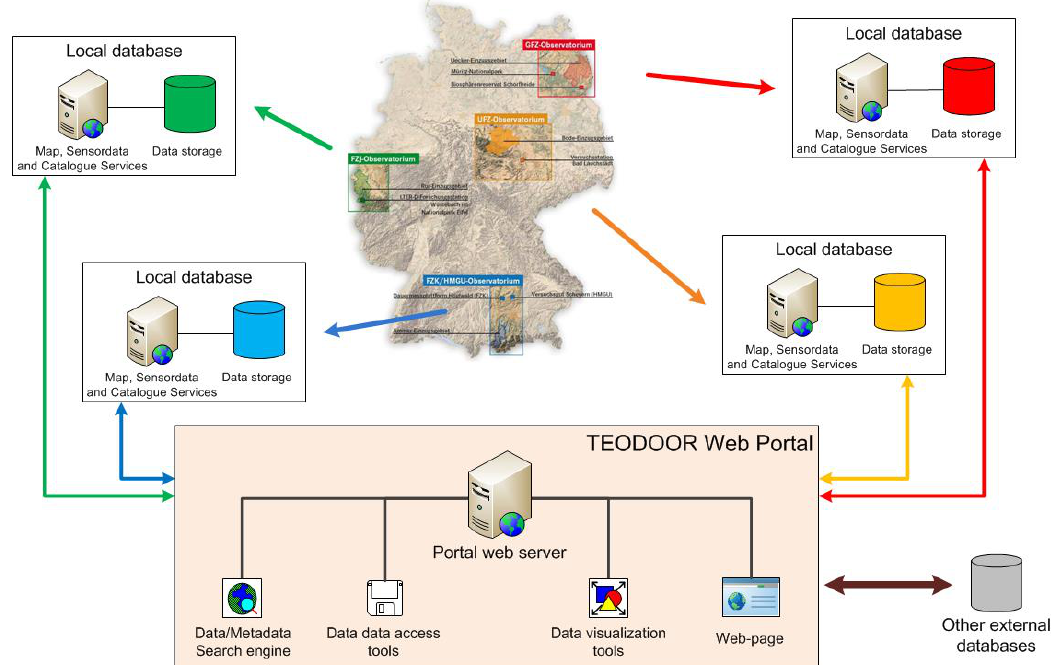
Figure 3: The design of the TERENO infrastructure for the distribution of the